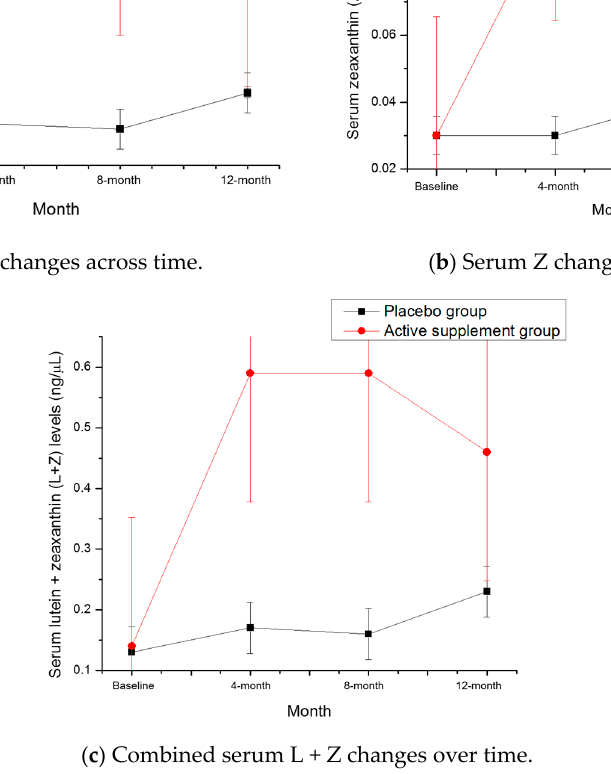
Figure 1. Serum changes from baseline to 12-month time points in: ( a ) lutein (L); ( b ) zeaxanthin (Z); and ( c ) and lutein + zeaxanthin (L + Z). Error bars represent the standard deviation of the mean at each time point.